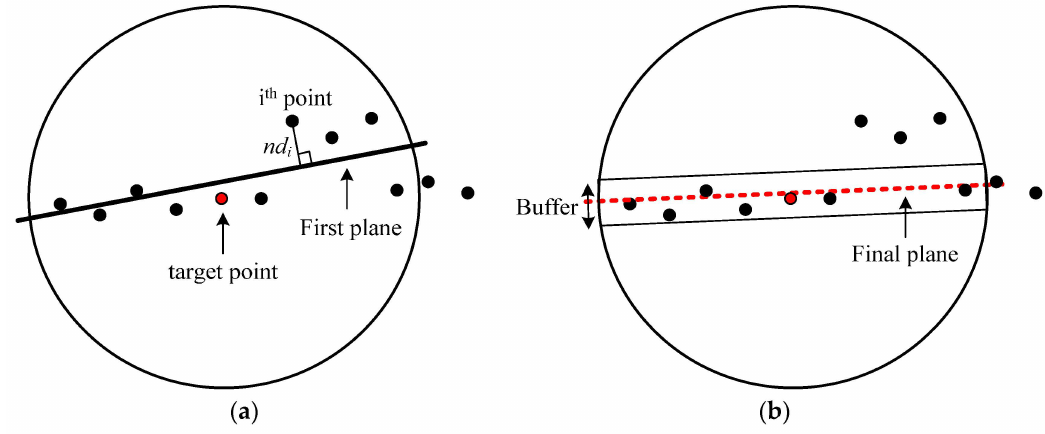
Figure 2. ( a ) The first fitted plane for a spherical neighborhood centered at a point in question; and ( b ) the final fitted plane derived through the iterative procedure using the weight function (side